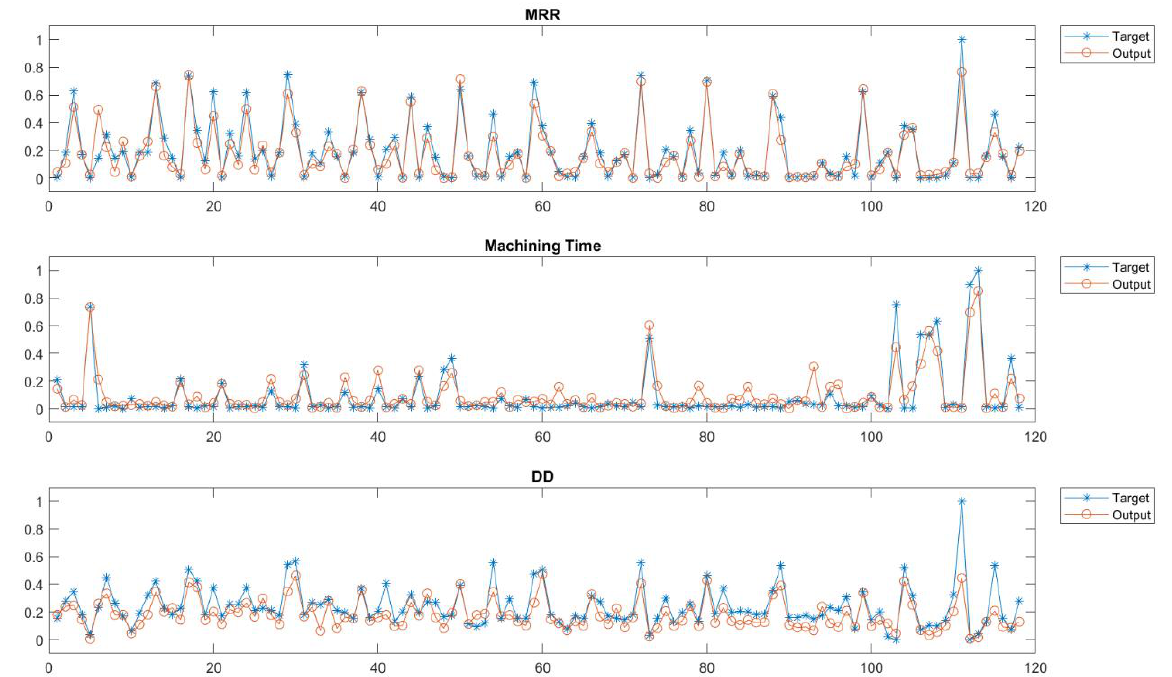
Figure 2. Prediction test data and actual values of Dimensional Deviation (Data close to 0 has a magnitude order equal to 10 −6 ).